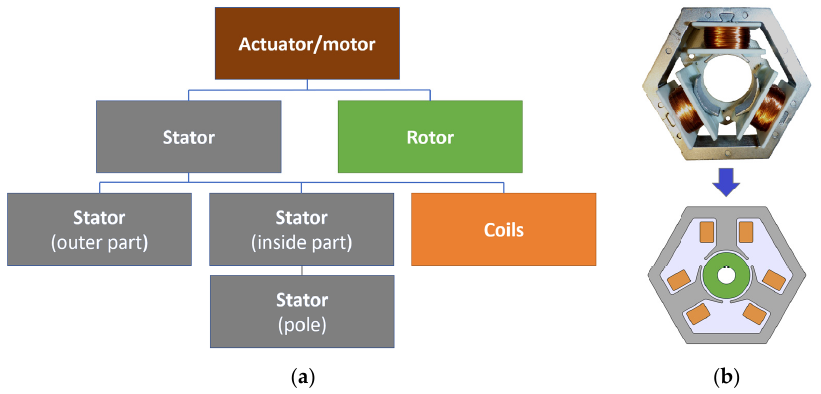
Figure 8. Analyzed configurations of the actuators/motors.